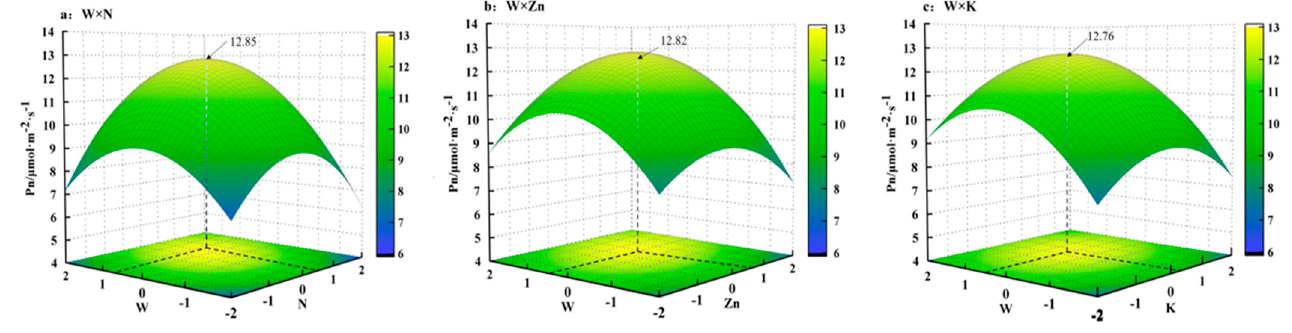
Figure 3. Combined effects of pairs of factors (a: 𝑊 × 𝑁 , b: 𝑊 × 𝑍𝑛 , c: 𝑊 > 𝐾 ) on net photosynthetic rate ( 𝑃𝑛 ).